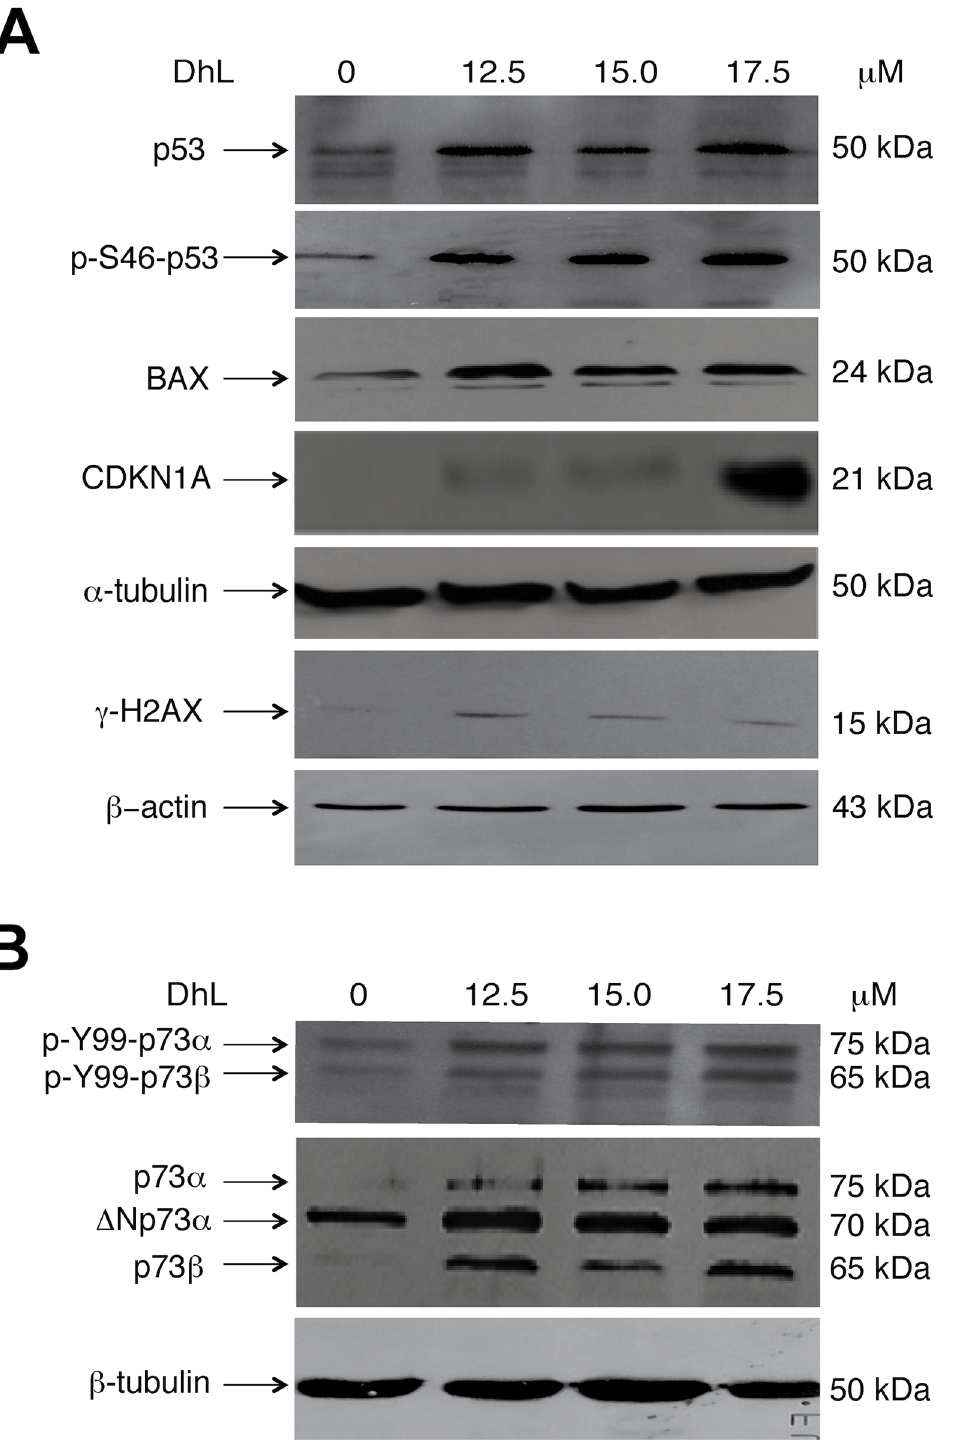
Fig 5. DhL induced the expression of proteins involved in cell cycle arrest and the apoptotic response of D384 cells. D384 cells were exposed to 12.5, 15 and 17.5 μ M DhL for 16 h. Total protein lysates were separated by 12 – 15% SDS-PAGE followed by western blot analysis with the indicated antibodies against BAX, CDKN1A, TP53, S46-p-TP53, and p139- γ H2AX, as shown in Panel A, and TP73 and Y99-p-TP73, as shown in Panel B. α -Tubulin and ß-actin were used as loading controls for total cell extracts.